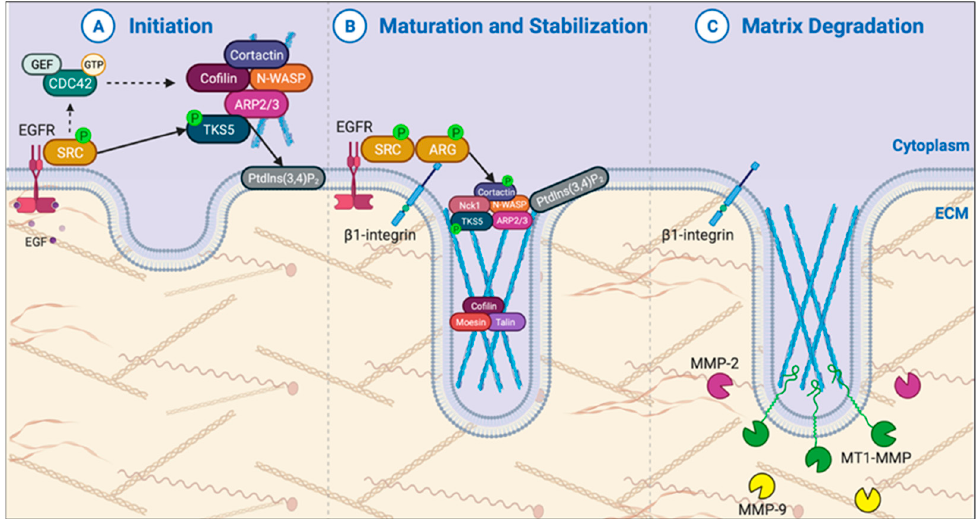
Figure 2. The initiation and assembly of functional invadopodia. ( A ) Invadopodia can be initiated by several intra- or extracellular cues (e.g., growth factor stimulation). Following this, Src kinase is autophosphorylated, leading to downstream activation of Cdc42 via a GEF (such as Vav1), phosphorylation of the scaffold protein TKS5, and formation of the invadopodia precursor core complex. The precursor core complex adheres to the membrane by binding to membrane-bound phosphatidylinositol-3,4-bisphosphate (PtdIns(3,4)P 2 ). ( B ) The maturation and stabilization of invadopodia involves